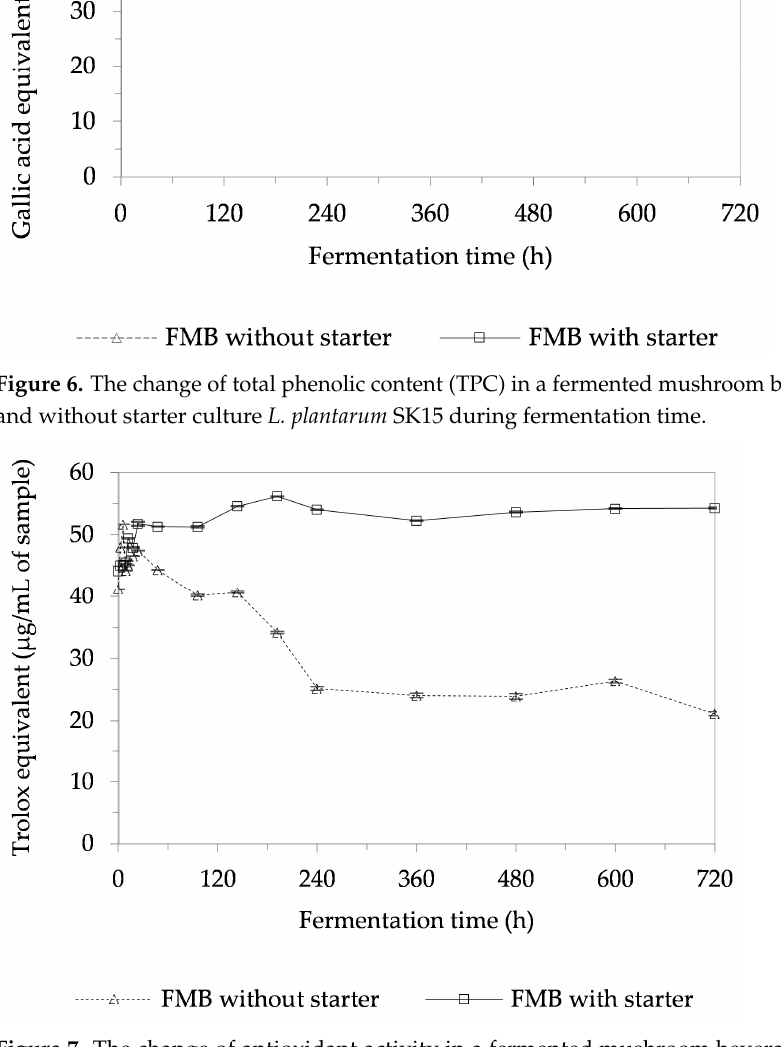
Figure 6. The change of total phenolic content (TPC) in a fermented mushroom beverage (FMB) with and without starter culture L. plantarum SK15 during fermentation time.